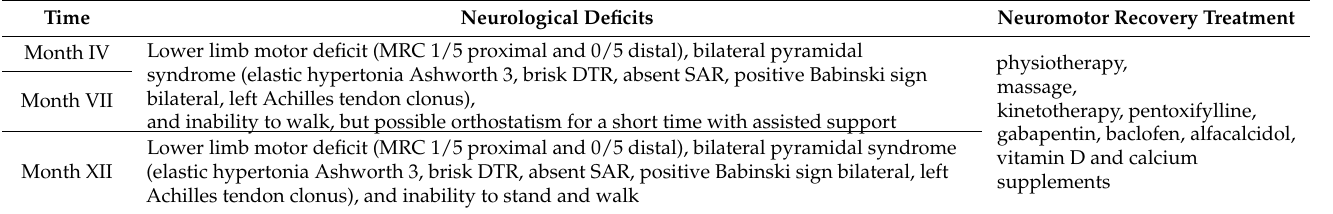
Table 3. Neurological deficits and recovery treatment over